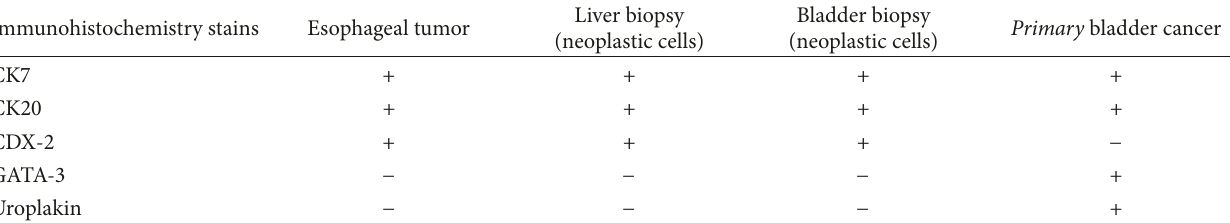
Table 1: Immunohistochemistry stains used to diagnose primary esophageal cancer, metastasis from an esophageal primary cancer, and primary bladder